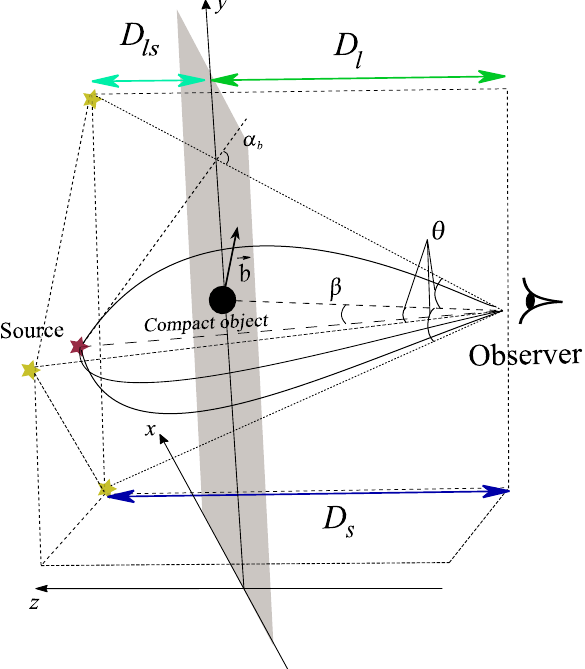
Fig. 6 Schematic plot of source-observer-lens